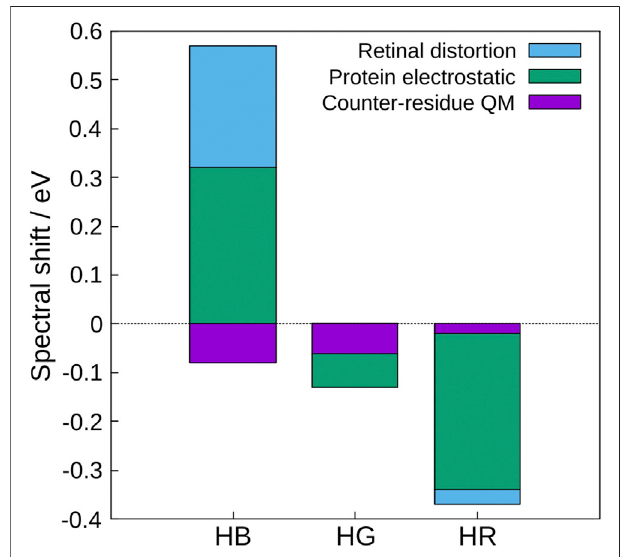
FIGURE 1 | Contributions to the spectral shifts of HB, HG, and HR calculated by the decomposition ofthe shifted energy into the distortion effect of the retinal structure, the electrostatic effect created by the protein environment, and the quantum effect of the counter-amino acid (glutamate anion). The value of bovine rhodopsin was used as a